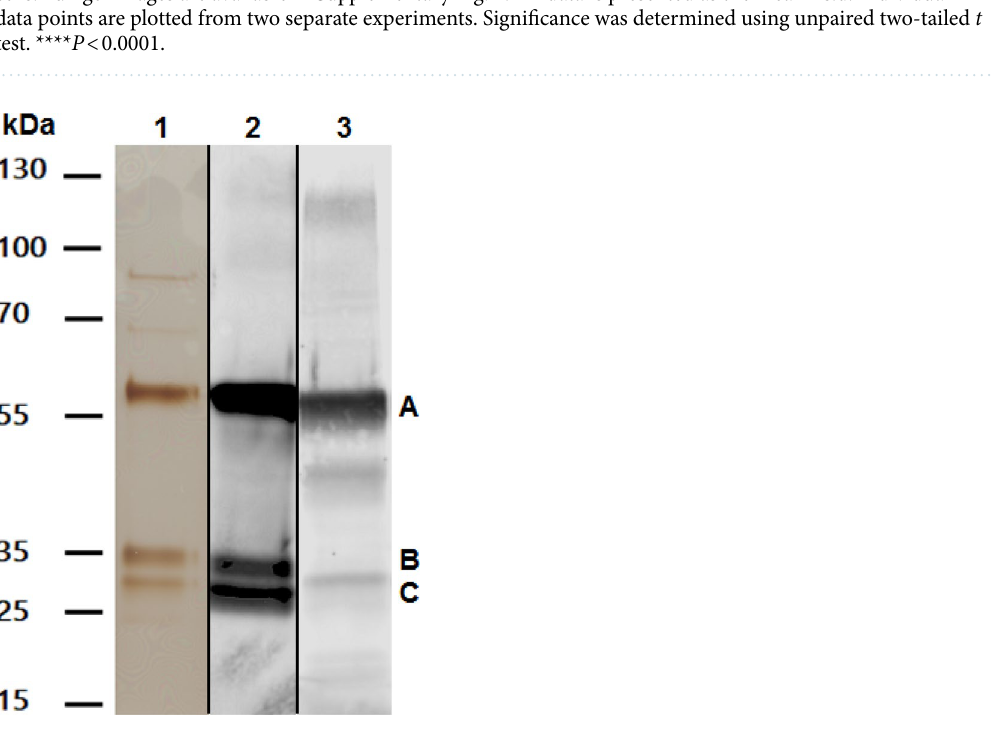
Figure 3. Purified His-GST-METTL7B: (Lane 1) SDS-PAGE silver stain of a representative gel showing purified His-GST-METTL7B (A). Gel lanes were loaded with a 1 µg total protein as determined by A 280. (Lane 2) Anti-GST antibody western blot of purified His-GST-METTL7B (1 µg total protein). (Lane 3) Western blot using anti-METTL7B antibody of purified His-GST-METTL7B (A) using 0.1 µg total protein. Molecular weight markers are shown to the left. The lower molecular bands, marked by letters B and C, are fusion protein fragments containing the dual His-GST affinity